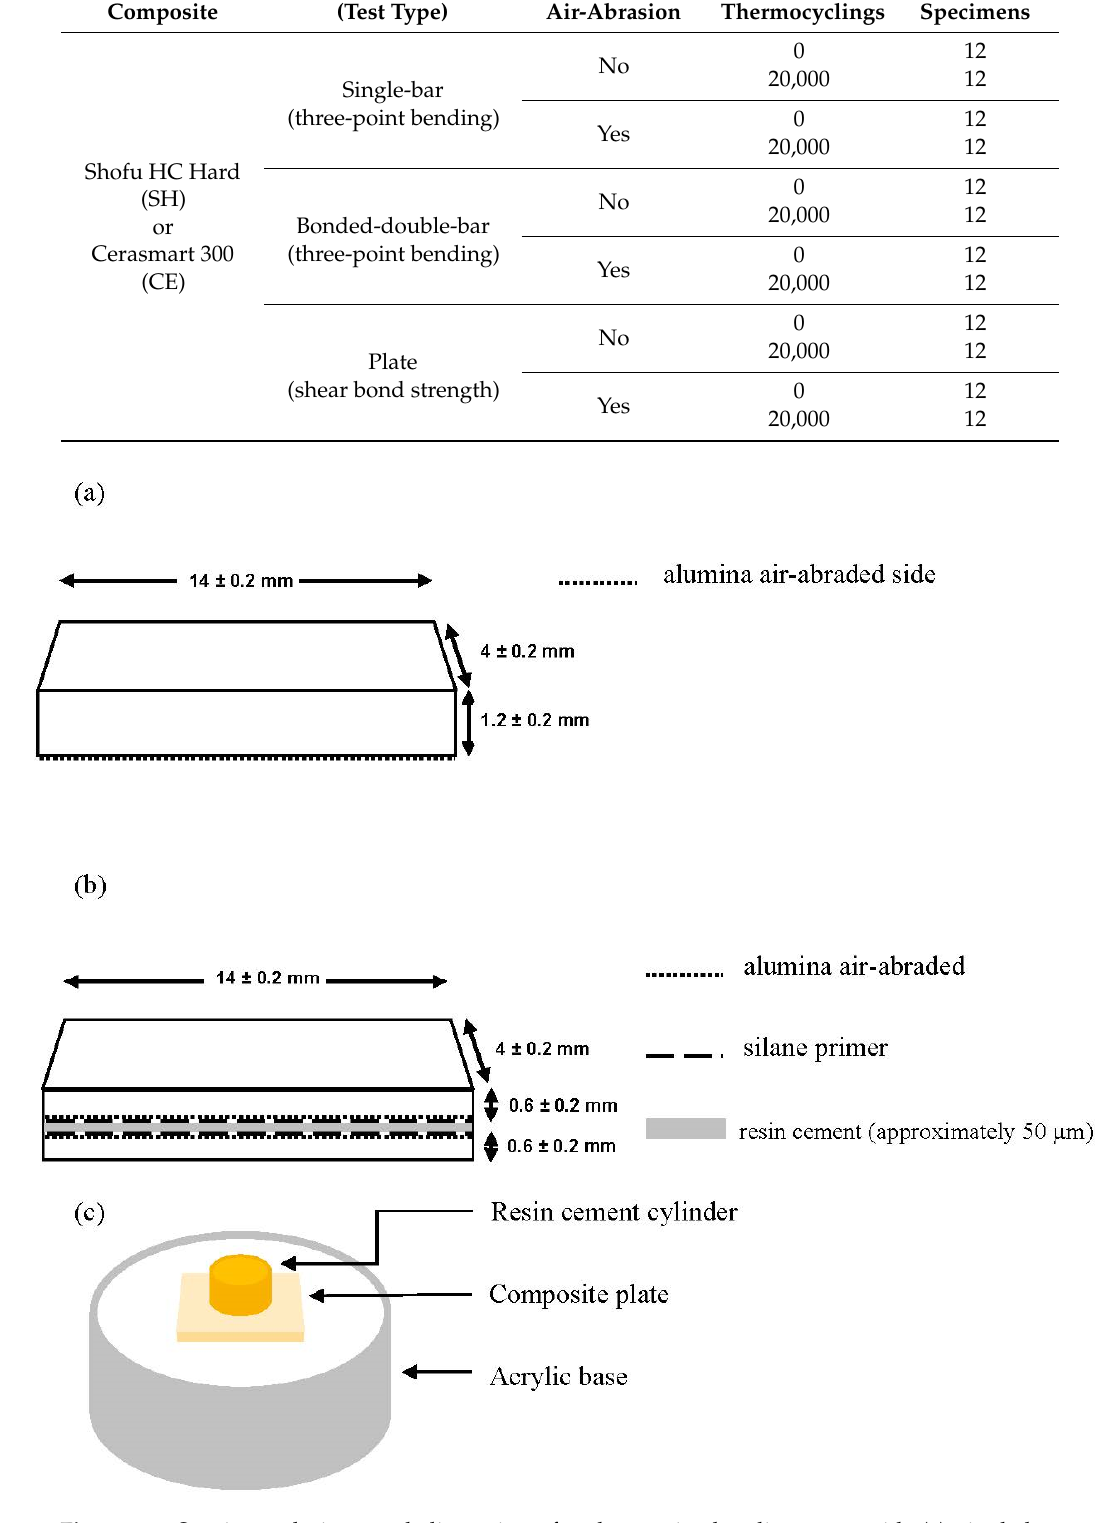
Figure 1. Specimen designs and dimensions for three-point bending tests with ( a ) single-bar, ( b ) bonded-double-bar, and ( c ) for shear bond strength (SBS) test with cylindrical specimen.